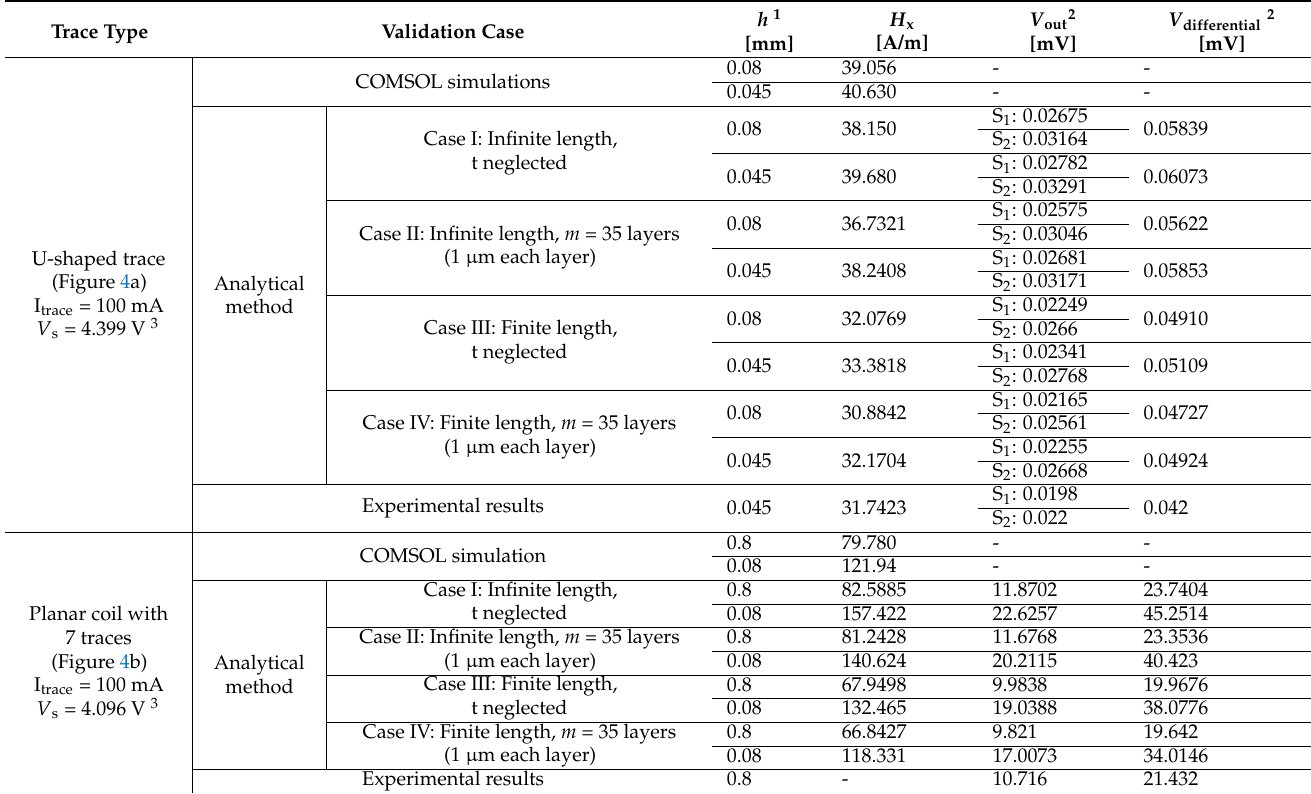
Figure 21. Magnetic field intensity obtained according to the analytical method in the sensor area, dependency on the number of traces in the case of a planar coil (the same parameters as for the 7 traces planar coil were used in this case). Note that m = 35 layers (1 μm each layer). Table 2. Comparative analysis between COMSOL simulation, analytical model, and experimental data.